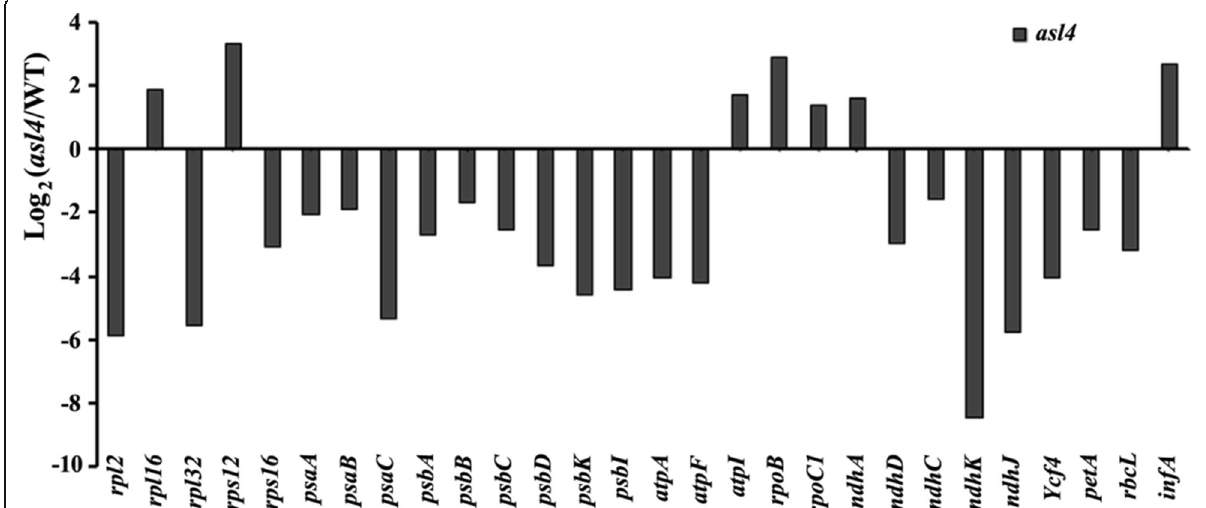
Fig. 7 Transcripts of plastid-encoded genes detected by transcriptome analysis. Total RNA was isolated from wild-type and asl4 mutant seedlings at the L3 stage and reverse-transcribed by random hexamer primers. The library was constructed and sequenced with an lllumina HiSeq 2000. Log 2 ( asl4 /WT) indicates the log 2 ratio of mRNA levels in asl4 mutant compared to wild